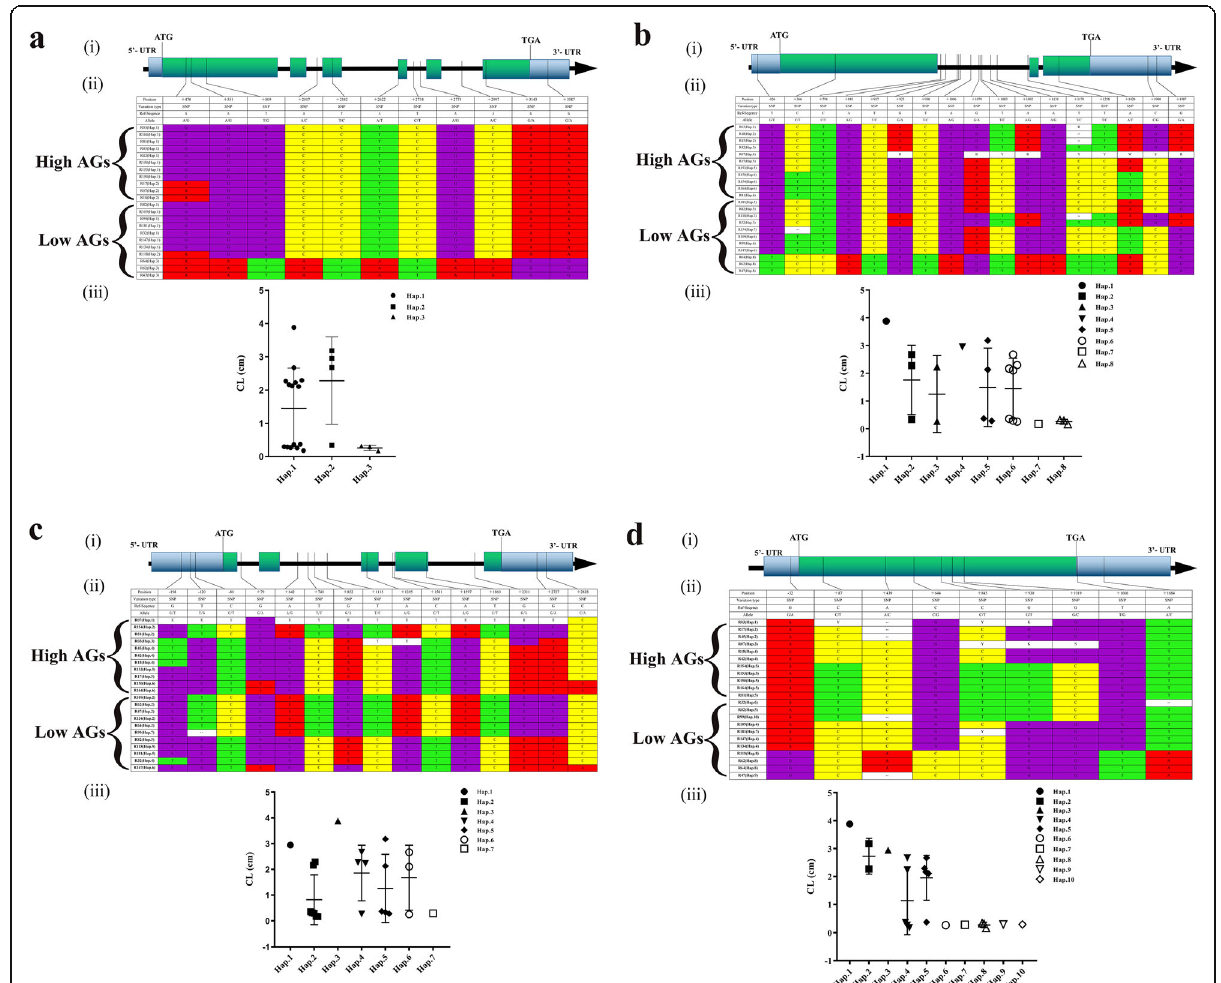
Fig. 8 Sequence analysis of four candidate genes in rice with high and low AGs. a The positions of four candidate genes Os01g0911700 , Os05g0560900 , Os05g0562200 and Os06g0548200 on chromosomes. b Sequence analysis of candidate gene Os01g0911700 . c Sequence analysis of candidate gene Os05g0560900. d Sequence analysis of candidate gene Os05g0562200 . e Sequence analysis of candidate gene Os06g0548200 . Notes: (i) the gene structure of four candidate genes is shown respectively, the blue region represents 5 ′ or 3 ′ UTR, the green region represents exon, the straight line represents intron, and the arrow shows gene direction. (ii) the detailed sequence changes of four candidate genes in rice materials with very high and very low AGs are shown, where the position number represents the position related to the “ ATG ” initiation codon; “ - ” represents the upstream of “ ATG ” ; and “ + ” represents the downstream of “ ATG ” . “ -- ” means that the gene is missing 1 bp. (iii) The phenotypic values of each